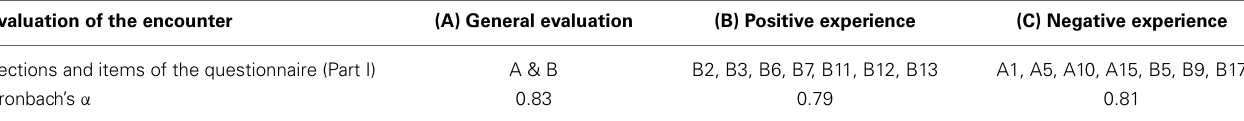
Table 1 | Cronbach’s α reliability test for selected items in the questionnaire (Part I) related to the participants’ general appreciation of NAO and of the interaction with it (A), the positive adjectives (B), and the negative adjectives (C) proposed to describe the participants’ affective state and opinion about the